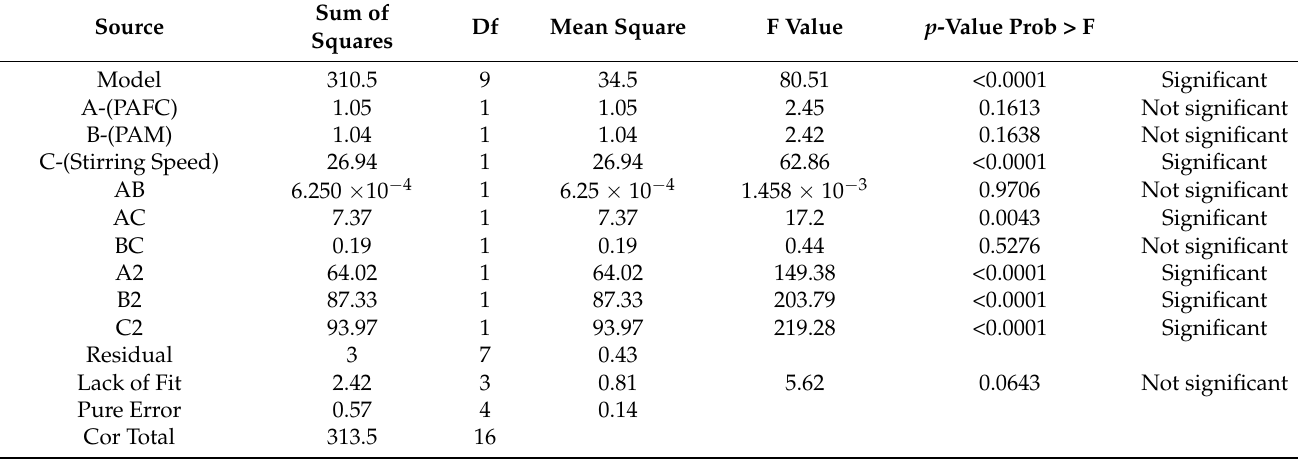
Figure 5. 3D surface plots and corresponding contour plots showing the removal rate of nano-CuO under the influences of ( A–D ) PAFC dosage and PAM dosage, ( B – E ) PAFC dosage and stirring speed and ( C – F ) PAM dosage and stirring speed. Table 3. Analysis of